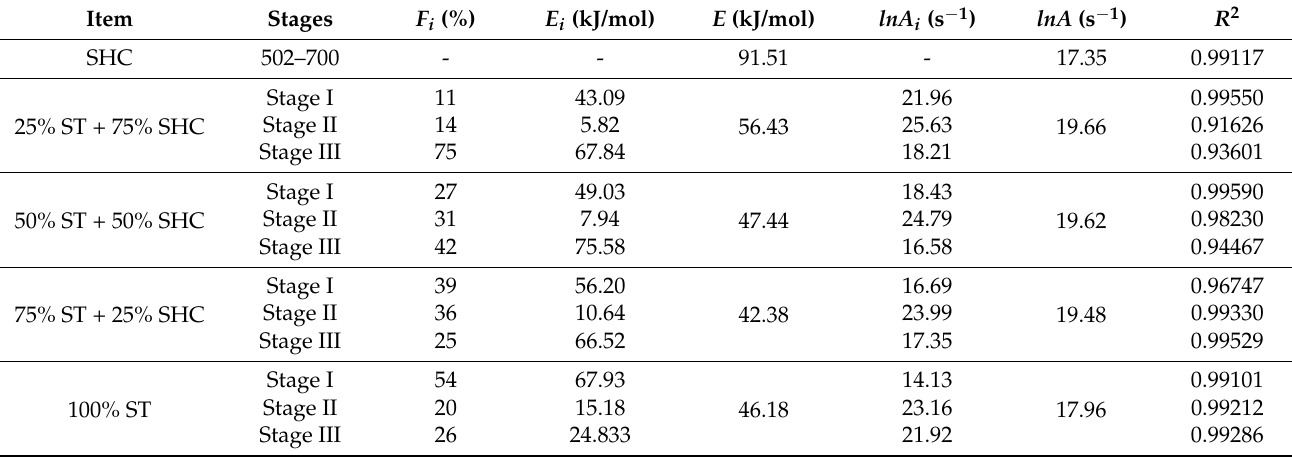
Figure 4. Kinetic analysis curves under different ST blending ratios. Table 2. Kinetic parameters under different ST blending ratios.